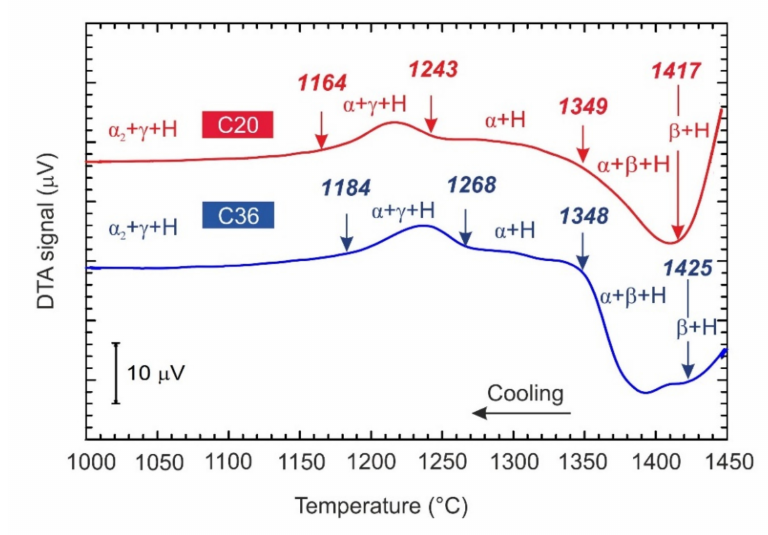
Figure 2. The typical DTA cooling curves of the studied C20 and C36